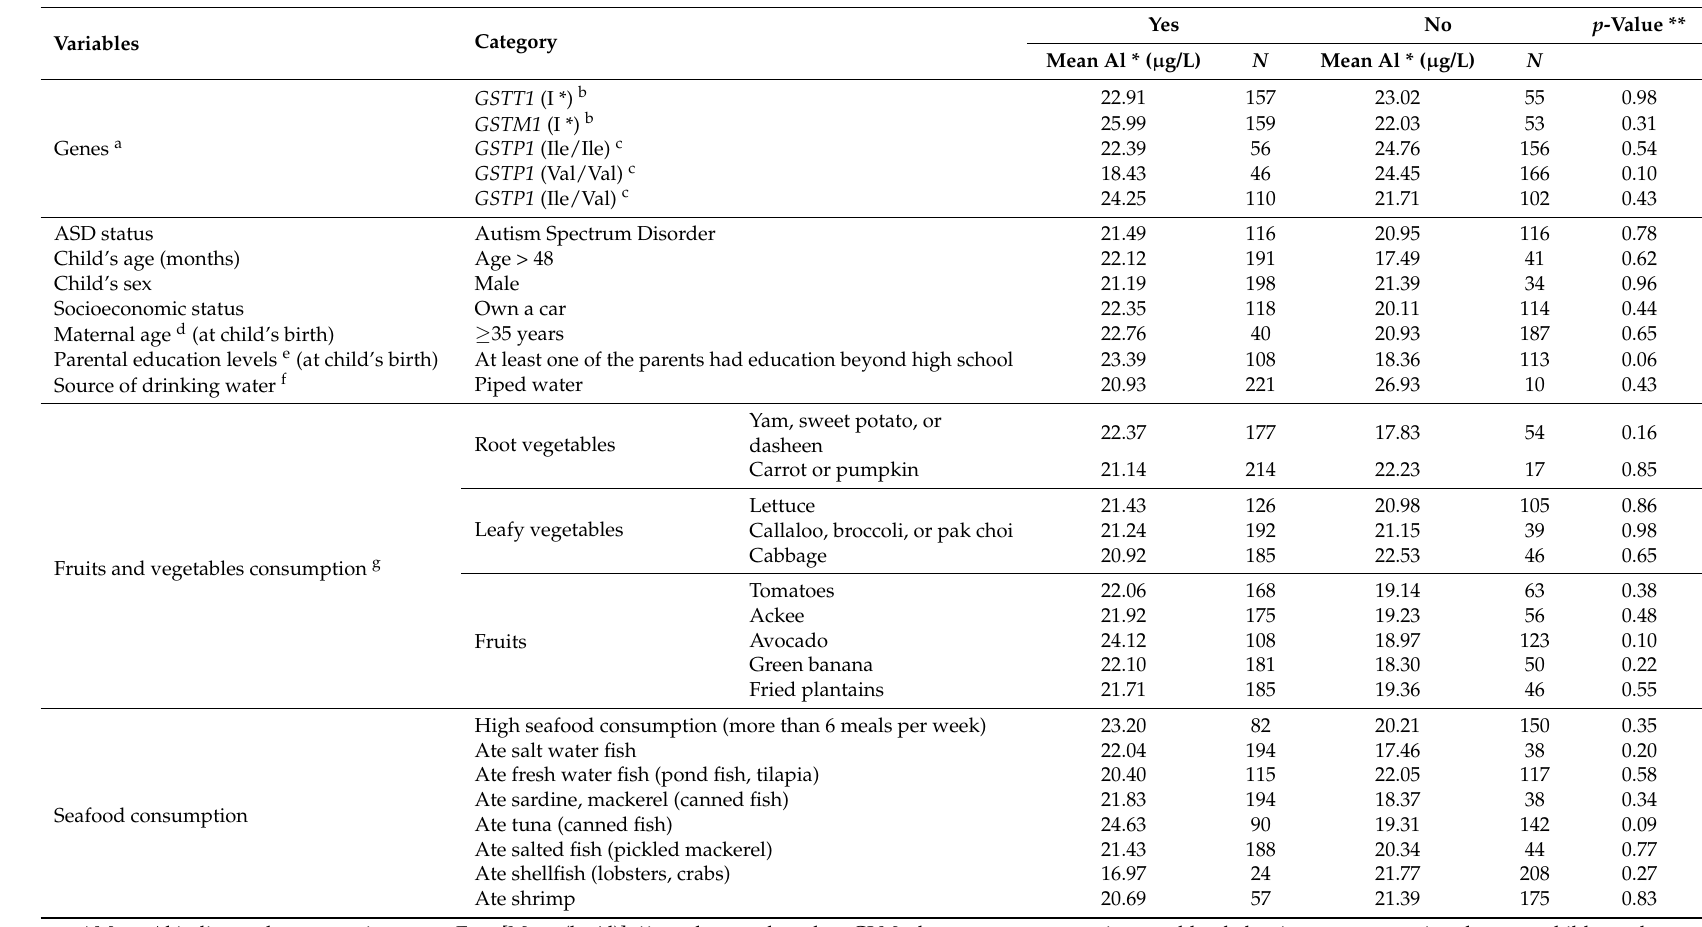
Table 3. Associations of various independent variables with blood aluminum concentrations based on univariable General Linear Models (116 matched pairs).